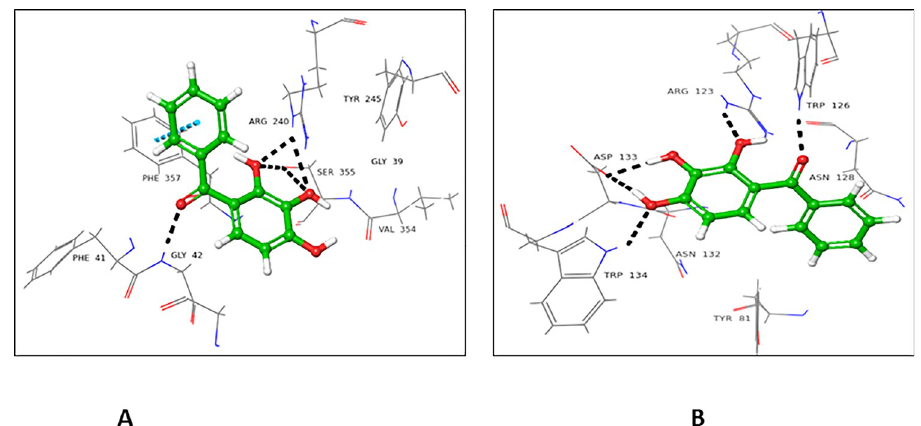
Fig 5. Interactions of compound 1 with ( A ) donor and ( B ) acceptor active site. 3D Ligand Interactions diagram; blue color dashed lines showing π - π stacking bond, while black represents hydrogen